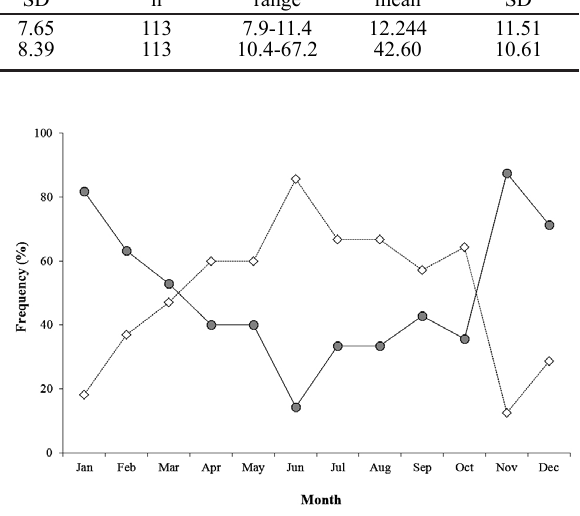
Table 1. – Summary statistics of the size (cm) and weight (g) ranges of S. lurida according to sex. SD, standard deviation. Variable